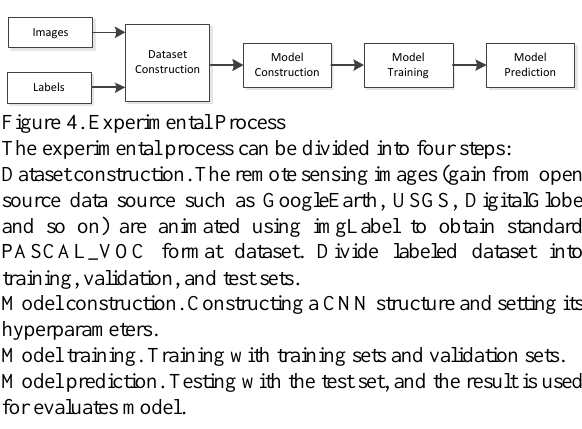
Table 1. Performance of airport detection Figure 7 shows airplane detected using our method.